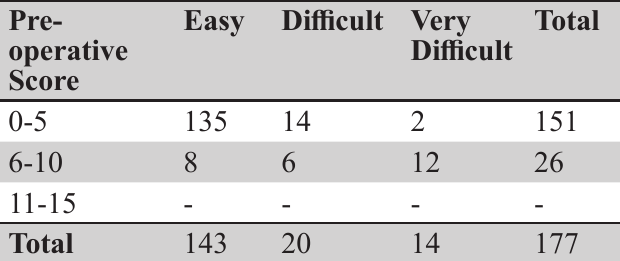
Table 4: Preoperative Score and the